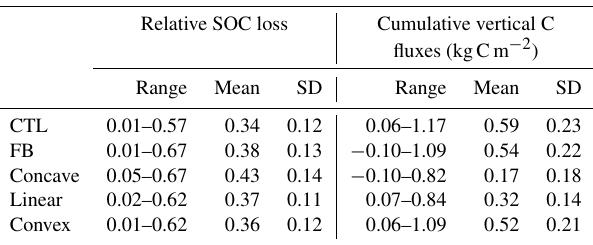
Table 4. Relative SOC loss and cumulative C fluxes (kgCm − 2 ) after 200 years of transient simulations for CTL and FBs. Results are given for the whole FB and for the sub-sets of FB corresponding to the concave relationship, the linear relationship and the convex